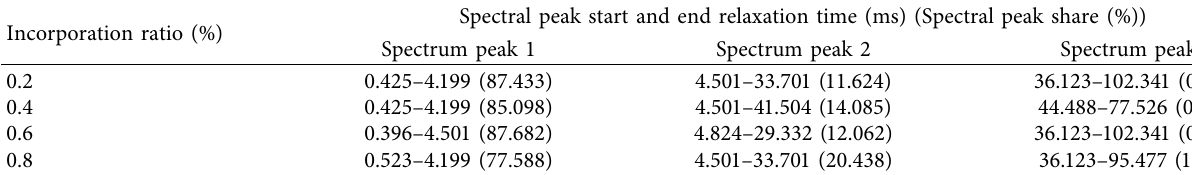
2 spectrum with different fiber ratios.